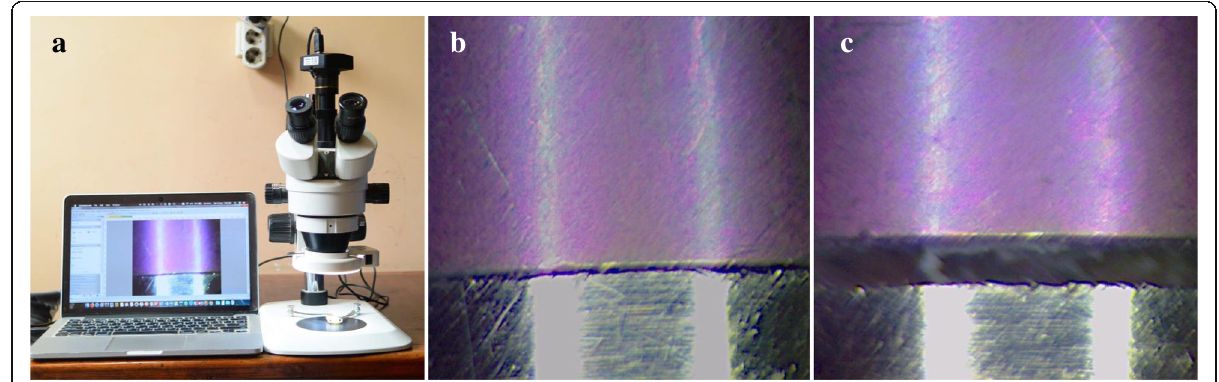
Fig. 4 a Stereomicroscope used. b No vertical/marginal discrepancy. c Presence of vertical and marginal